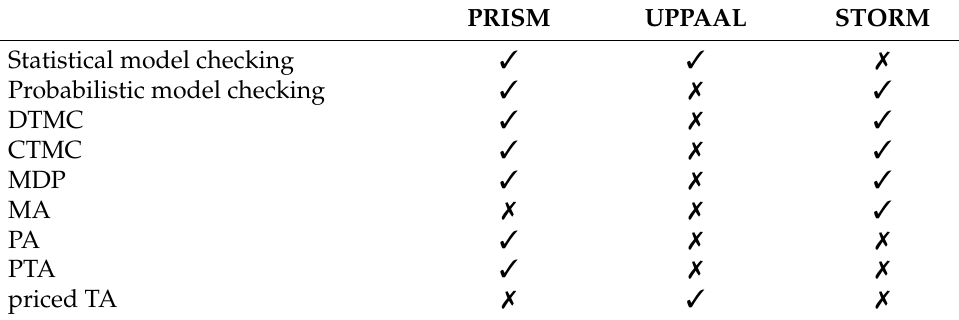
Table 7. Probabilistic model checkers’ feature